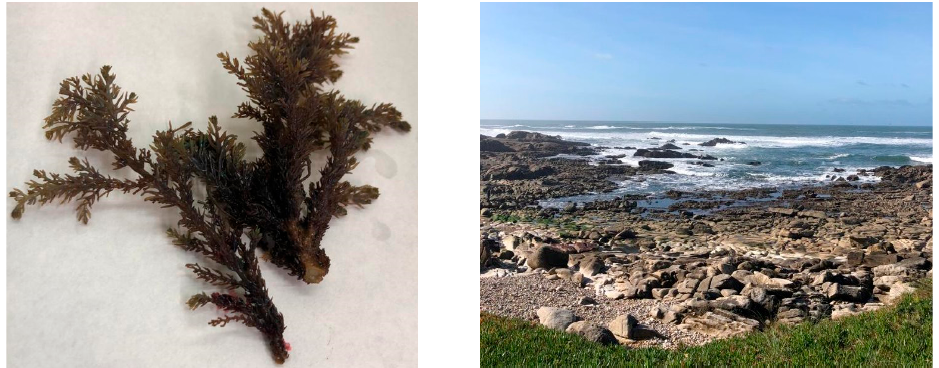
Figure 2. Example of specimen Ericaria selaginoides , previously designated as Cystoseira tamariscifolia, ( left ) collected from the north coast of Portugal ( right ).